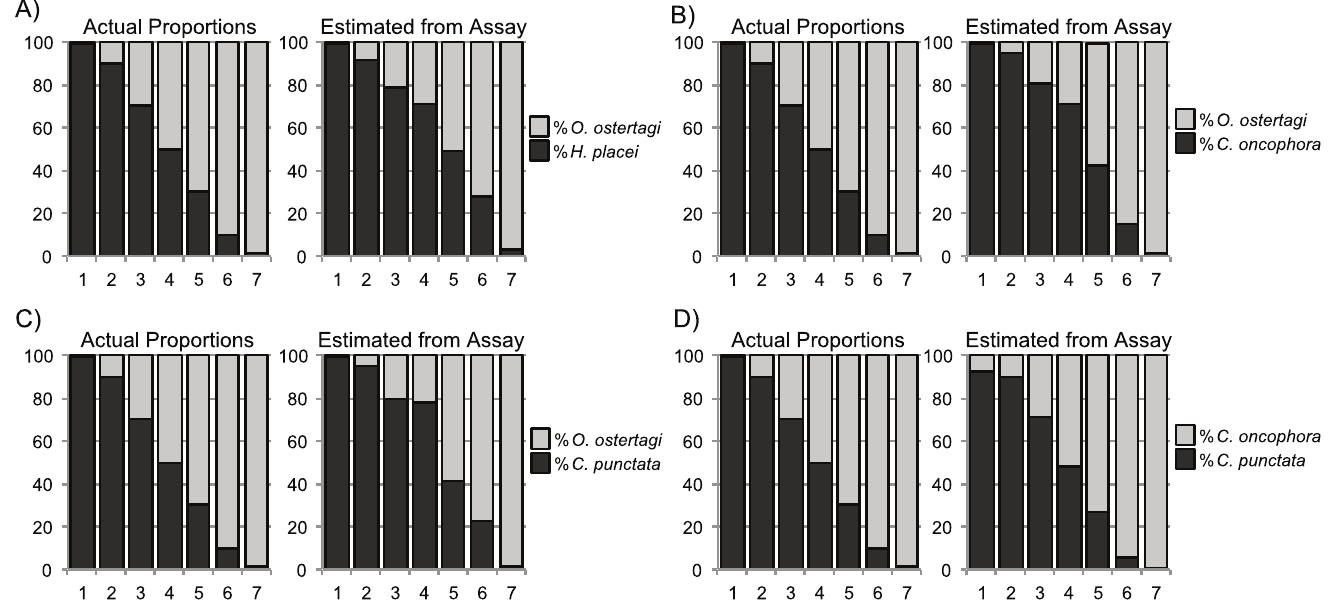
Fig 3. The determination of species proportions of a series of pairwise parasite species combinations using the amplicon sequencing assay. DNA lysates were prepared from mock pools of 2000 L3 larvae comprising varying proportions of two different nematode species and the amplicon sequencing assay applied. Panel 3A, O . ostertagi and H . placei ; Panel 3B, C . oncophora and O . ostertagi ; Panel 3C, O . ostertagi and C . punctata ; Panel 3D, C . oncophora and C . punctata . The left hand chart of each pair shows the expected results based on the known numbers of larvae added to each pool and the right hand chart of each pair shows the results of the amplicon sequencing assay (after the application of the appropriate correction factors). The ratios by which the two species of each pair vary from left to right on each chart are as follows: Column 1, 99:1; Column 2 90:10; Column 3; 70:30, Column 4, 50:50; Column 5; 30:70, Column 6; 10:90 and Column 7;